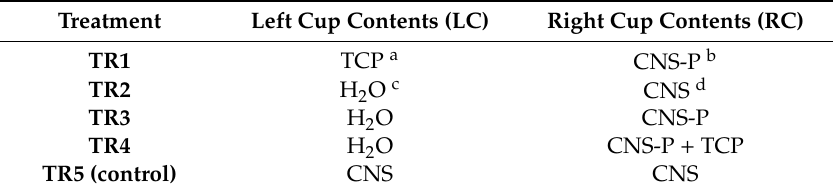
Table 1. Description of treatments applied to either half of the roots in a split-root system. Left and right halves refer to the sides of an observer facing the system. Treatment Left Cup Contents (LC) Right Cup Contents (RC) TR1 TCP